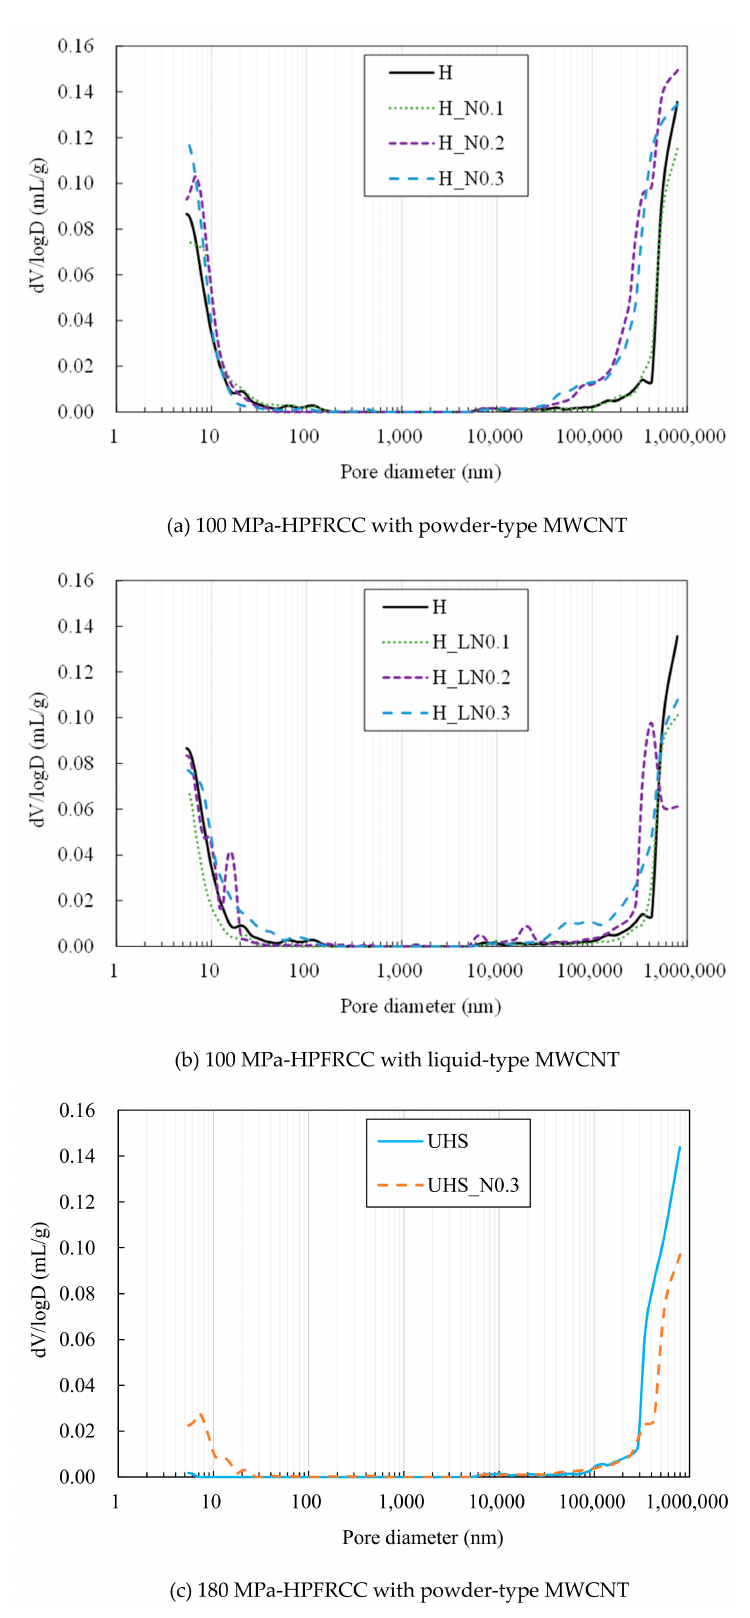
Figure 13. Pore size distributions of 100 MPa and 180 MPa-HPFRCC without steel fiber measured by MIP. ( a ) 100 MPa-HPFRCC with powder-type MWCNT; ( b ) 100 MPa-HPFRCC with liquid-type MWCNT; ( c ) 180 MPa-HPFRCC with powder-type